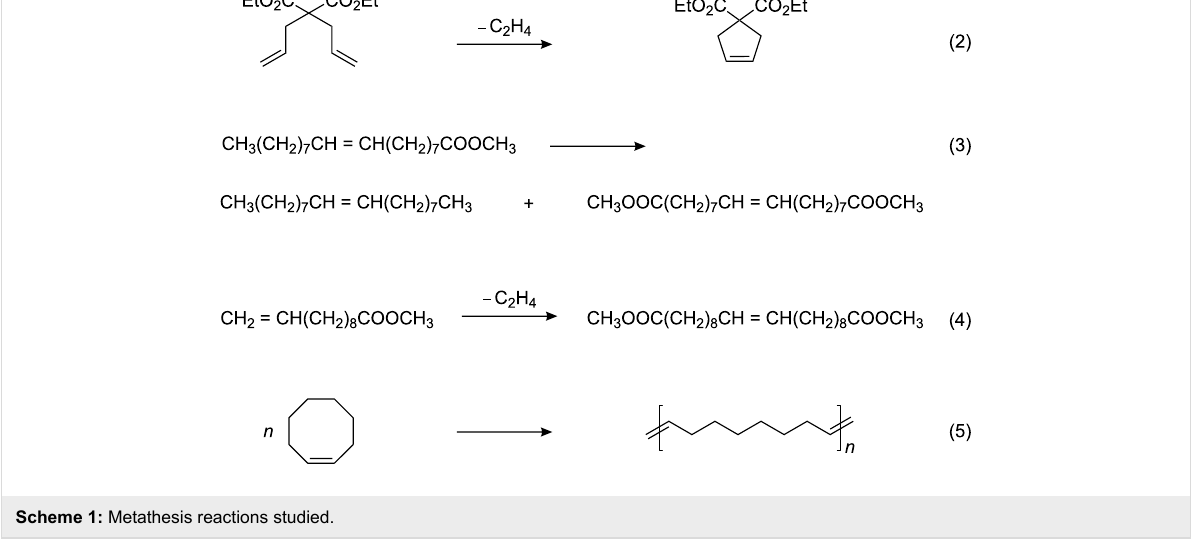
Scheme 1: Metathesis reactions studied.